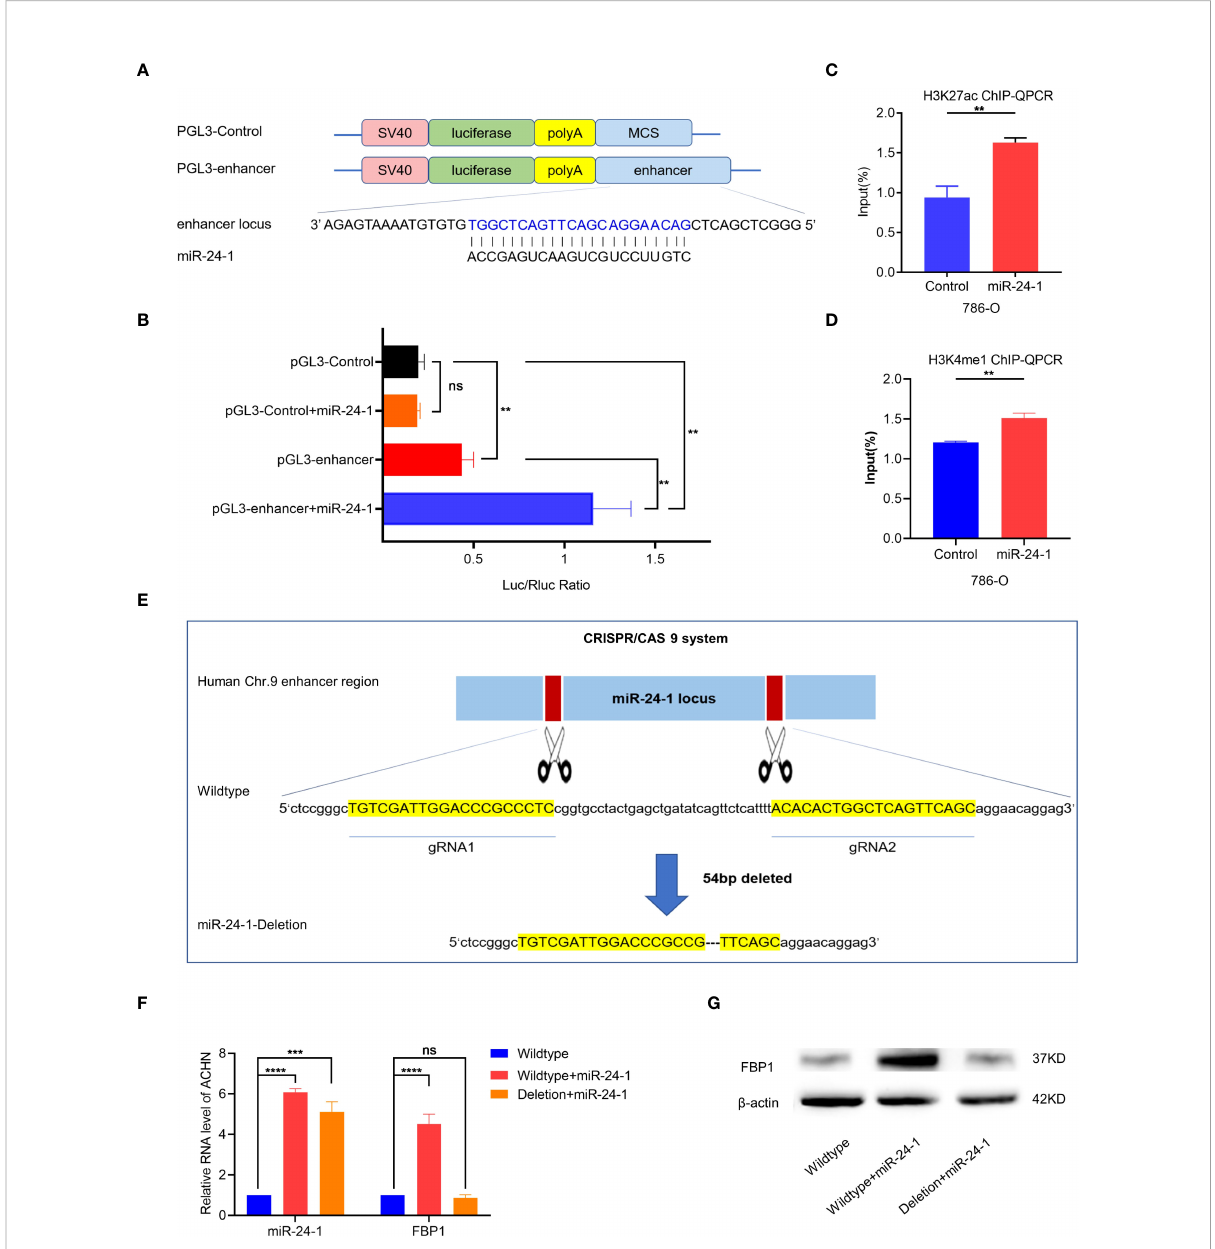
FIGURE 4 MiR-24-1 mechanistically activates FBP1 through enhancer. (A) The schematic diagram of pGL3-enhancer vector construction in dual luciferase reporter gene assay. The enhancer sequence containing miR-24-1 DNA locus located on 60 kb upstream from FBP1 was inserted into pGL3 vector to construct pGL3-enhancer vector. (B) The enhancer sequence containing miR-24-1 DNA locus can increase the activity of reporter gene. Co-transfection of miR-24-1 expression vector and pGL3-enhancer vector induced an increase of enhancer activity in dual luciferase reporter gene assay. (C, D) More enrichment of H3K27ac (C) and H3K4me1 (D) on miR-24-1 locus was observed by ChIP-qPCR after overexpressing miR- 24-1. (E, F) The schematic diagram of CRISPR/Cas9 system. A deletion of 54bp in enhancer sequence containing miR-24-1 (E) was con fi rmed by Sanger sequencing (F) . (G) The mRNA expression levels of FBP1 were detected by qPCR. FBP1 was increased when overexpressing miR-24-1, yet failed to be activated when enhancer was deleted. (G) Similarly, the protein expression levels of FBP1 were detected by western blot. Results are shown as mean ± S.D., ****p < 0.0001, ***p < 0.001, **p < 0.01, ns means not signi fi